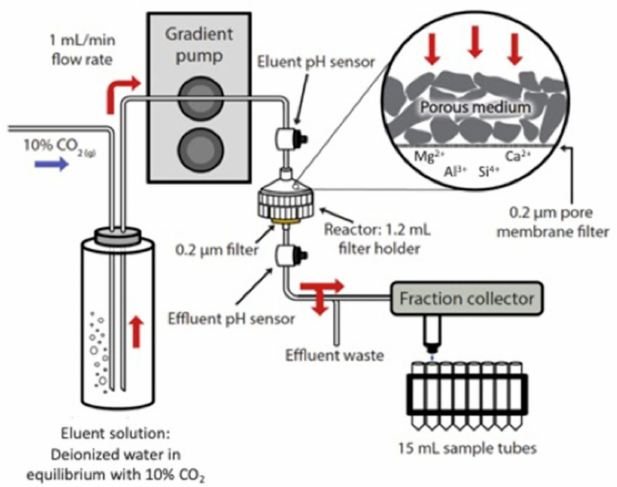
Figure 2. Process flow diagram of lab-scale flow-through dissolution apparatus. Adapted with permission from